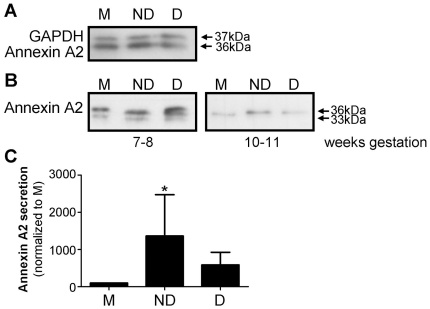
Annexin A2 in extravillous trophoblast cell lysate and conditioned media following treatment with media alone (M), non-decidualized (ND) or decidualized (D) human endometrial stromal cell conditioned media (n = 6).A. Western blot showing annexin A2 and GAPDH loading control in EVT lysates. B. Western blot showing annexin A2 in EVT conditioned media. Shown are representative blots of annexin A2 in EVT isolated from gestational weeks 7–8 (n = 3) and 10–11 (n = 2). Two bands (36 & 33 kDa) for annexin A2 were observed in the conditioned media from EVT isolated from gestational weeks 7–8. C. Densitometry of annexin A2 from conditioned media (all weeks of gestation; n = 6). The ratio of annexin A2:total cellular protein has been normalized to media control. *, signficant difference to M, p<0.05.